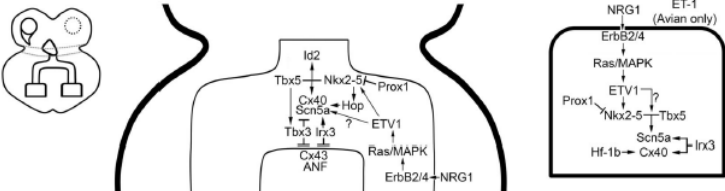
Figure 5. Ventricular conduction system gene regulatory network. Schematic overview of the cardiac conduction system, left panel; His bundle and bundle branch schematic, center panel; Purkinje cell schematic, right panel (Reproduced with permission from [14]).